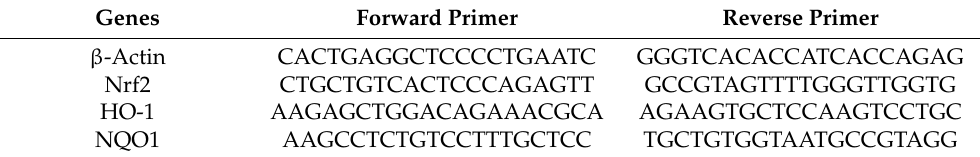
Table 1. Sequences of primers for quantitative real-time